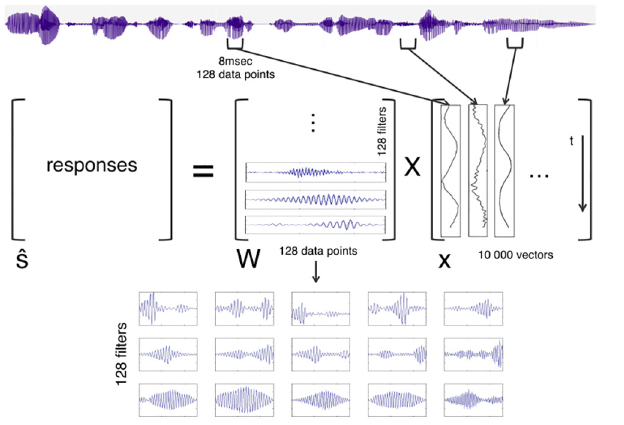
Fig 1. Algorithm. The ICA algorithm used in the current